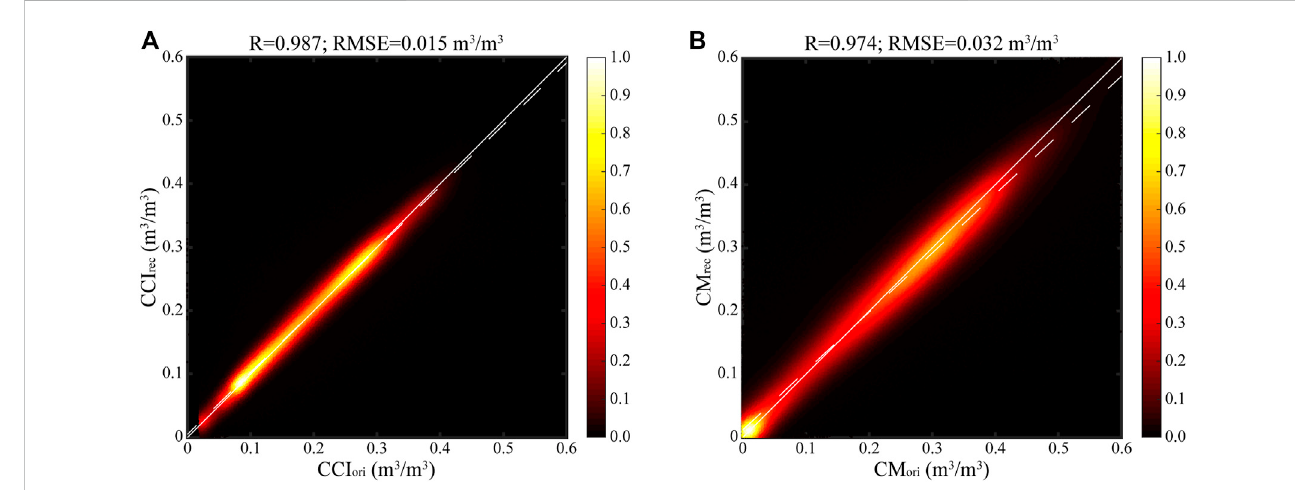
FIGURE 6 The scatter plots of arti fi cial missing values and their reconstructions for CCI (A) and CM (B) data respectively. The colorbar indicates thedata frequency.